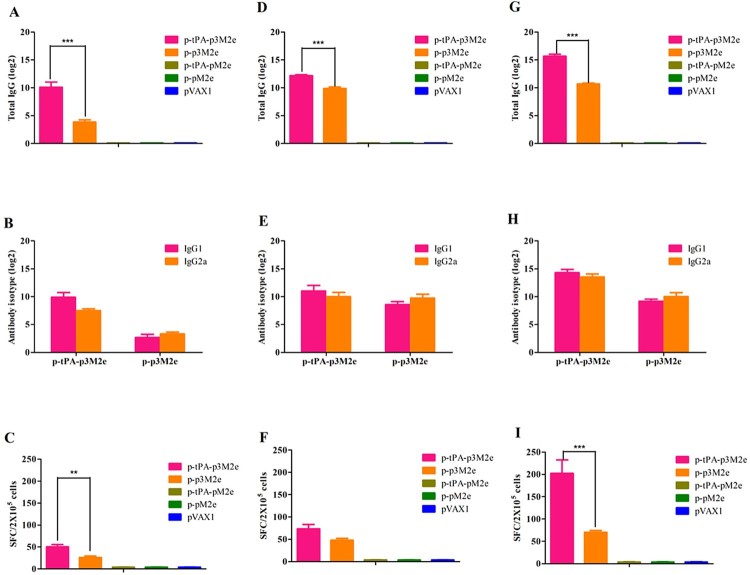
M2e-specific humoral and cellular immune responses. M2e-specific IgG, IgG1, and IgG2a titers were determined by ELISA. Cellular immune response induced by M2e-immunized mice detected by ELISpot. Data are expressed as spot-forming cells (SFCs) responding to peptide-specific IFN-γ secretion and are presented as the means ± standard deviation. [A, B, C (once immunization), D, E, F (twice immunization) and G, H, I (three times immunization)]. Statistical significance was defined as ***p < 0.001, **p < 0.01.